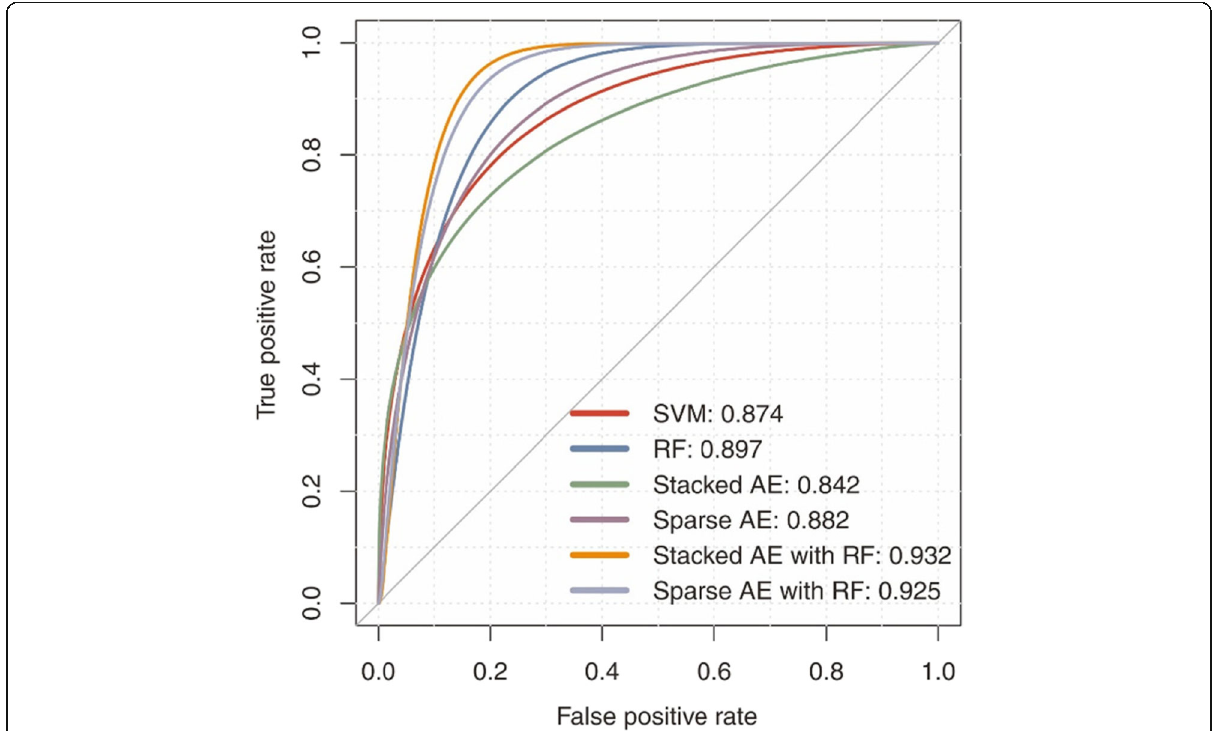
Fig. 10 The area under the curves for prediction ratio and validation of landslide susceptibility maps produced by the six